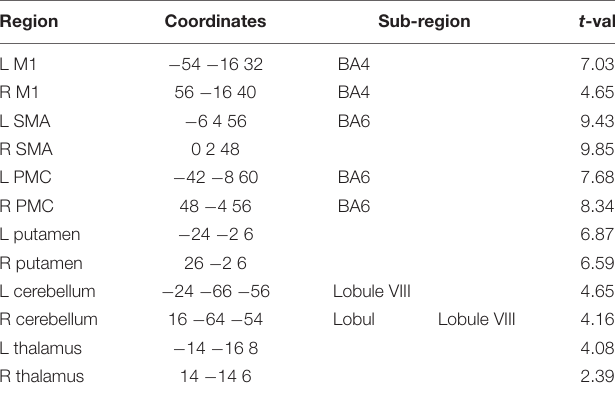
TABLE 4 | Dynamic causal modeling nodes: Task > Baseline. Region